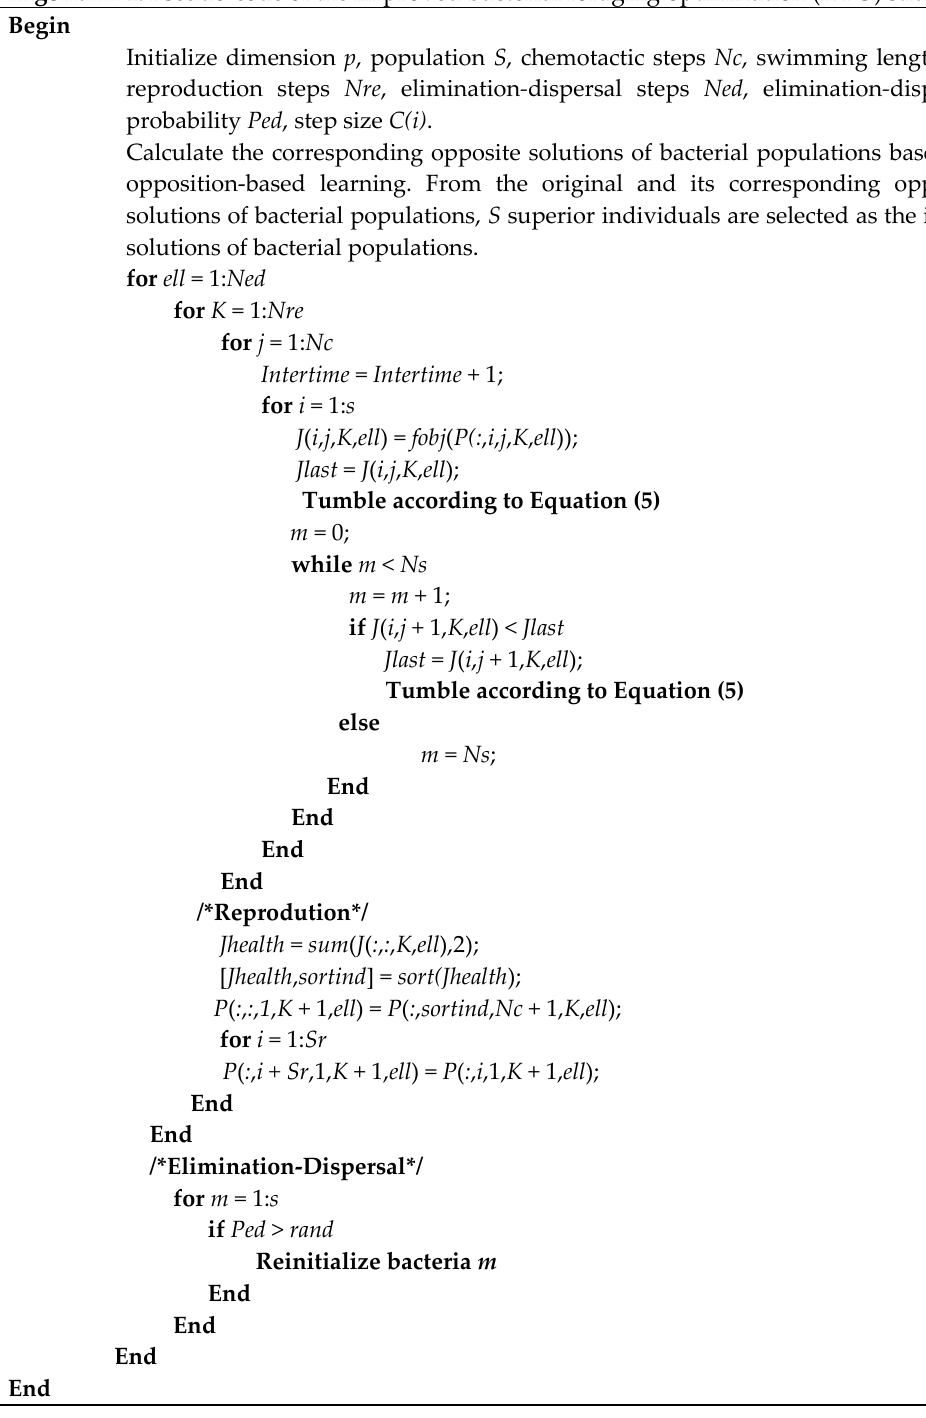
Algorithm 1. Pseudo-code of the improved bacterial foraging optimization (IBFO) strategy.